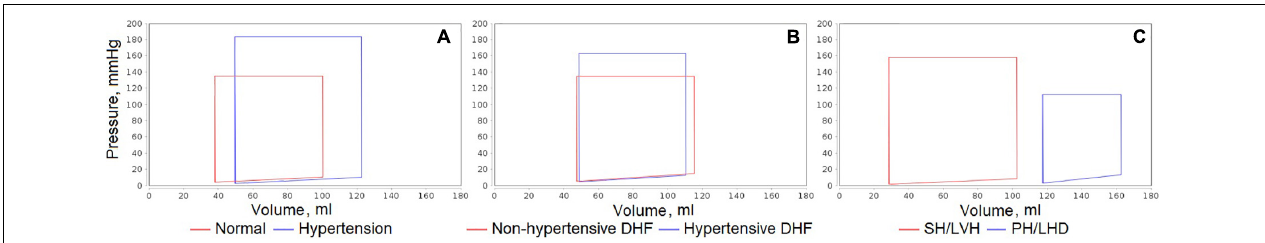
Values, which we evaluated using average clinical characteristics of patients in corresponding experimental studies, are marked with blue color. LV, left ventricle; RV, right ventricle; HF, heart failure; LVH, left ventricular hypertrophy; PH, pulmonary hypertension.